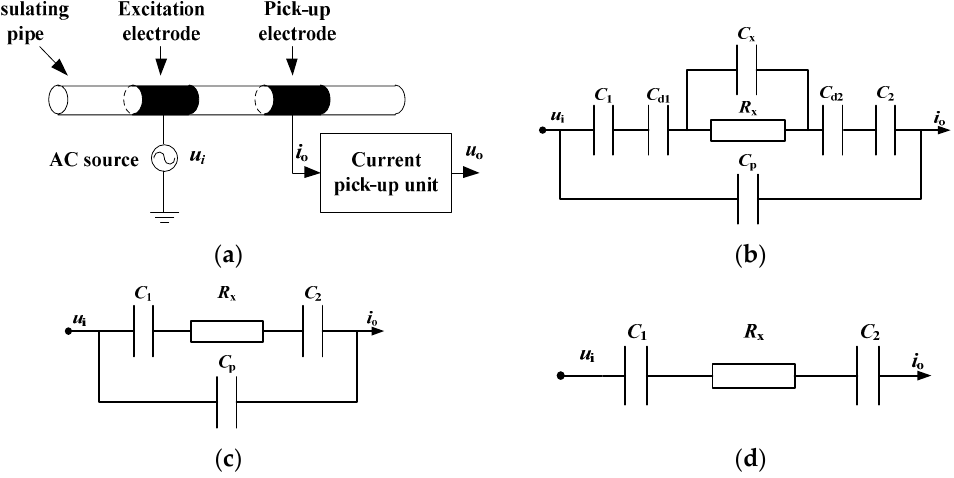
Figure 1. Principle of a typical C 4 D sensor: ( a ) Construction; ( b ) Equivalent circuit; ( c ) Simplified equivalent circuit; ( d ) Further simplified equivalent circuit.